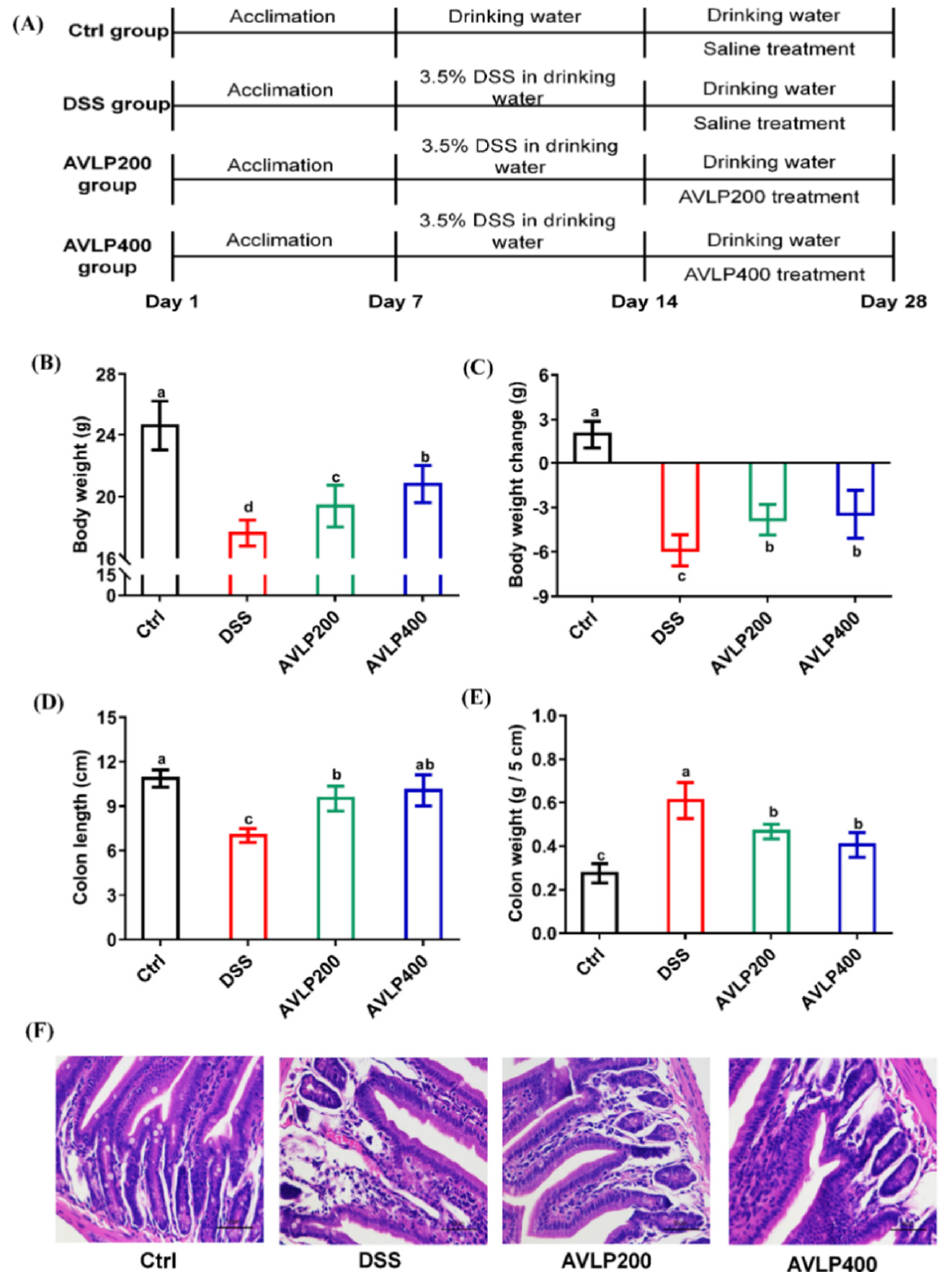
Figure 2. Effects of AVLP on pathological symptoms in colitis mice. ( A ) Schematic diagram of experimental design. ( B ) Body weight. ( C ) Body weight change (14–28th day). ( D ) Colon length. ( E ) Colon wet weight (5 cm). ( F ) Representative images of colon sections. Significant differences ( p < 0.05) are indicated with different letters.